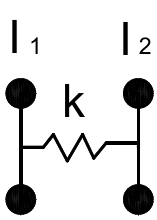
Figure 4. Scheme of masses of piston compressor drive system.